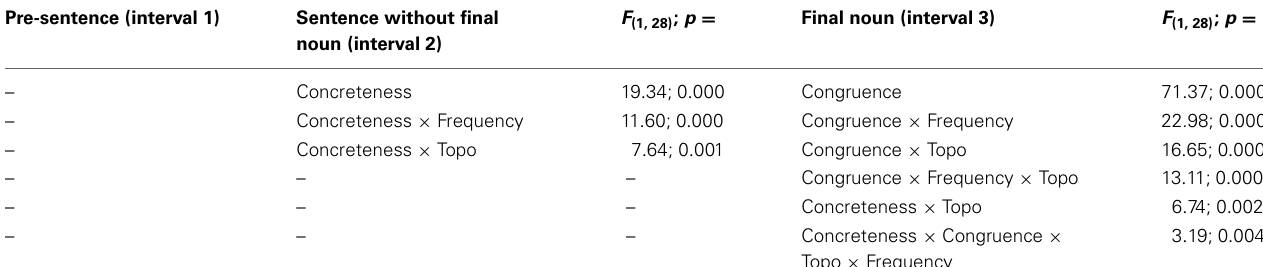
Table 2 | Repeated measures ANOVAs: significant main effects and interactions for coherence values in the three sentence intervals. Pre-sentence (interval